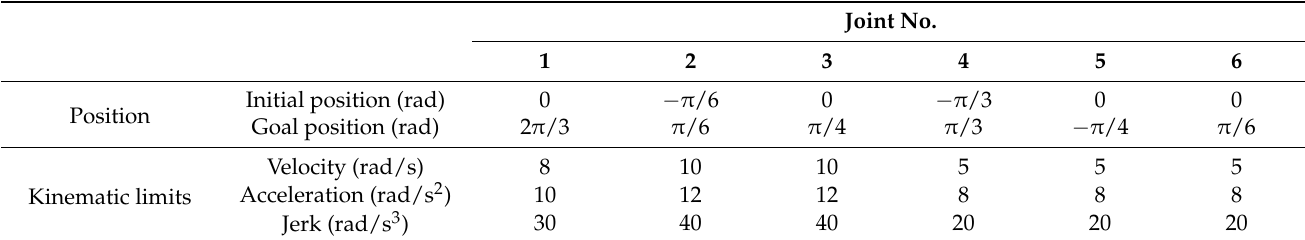
Table 1. Desired positions and kinematic limits of the test task.